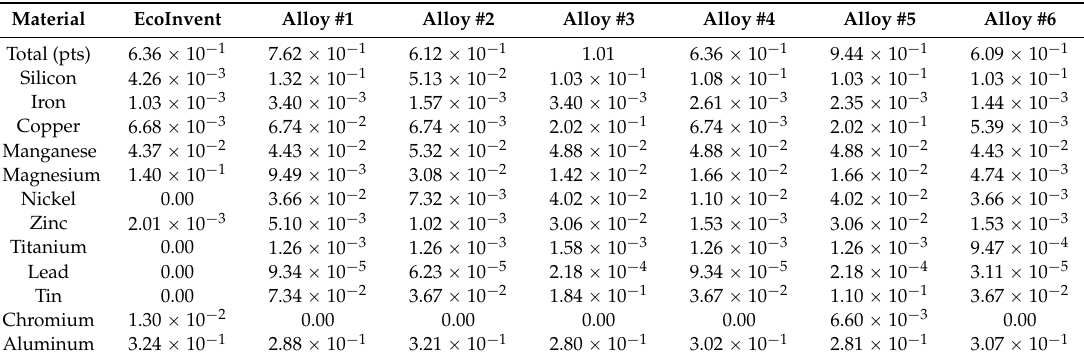
Table 7. Environmental impact of 1 kg of the studied aluminum